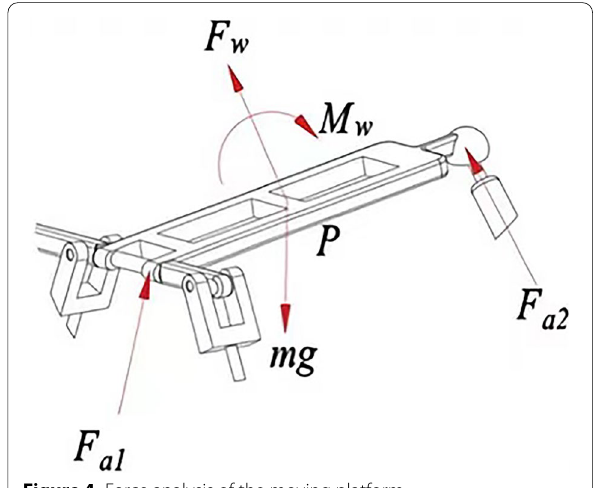
Figure 4 Force analysis of the moving platform